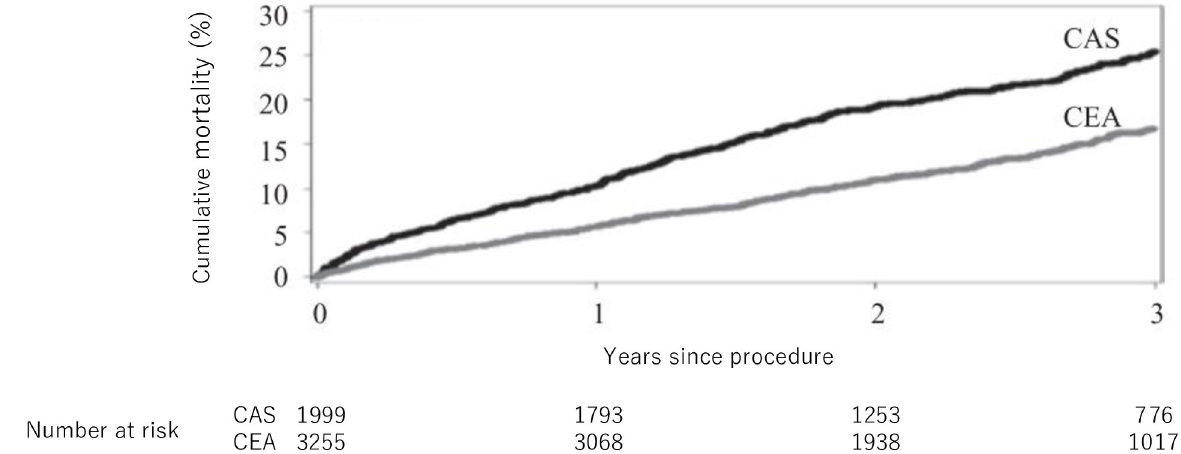
Fig 2. 3-year cumulative incidence of death among the Medicare-linked SVR-VR patients, by procedure. Abbreviations: CAS = Carotid Stenting; CEA = Carotid endarterectomy.